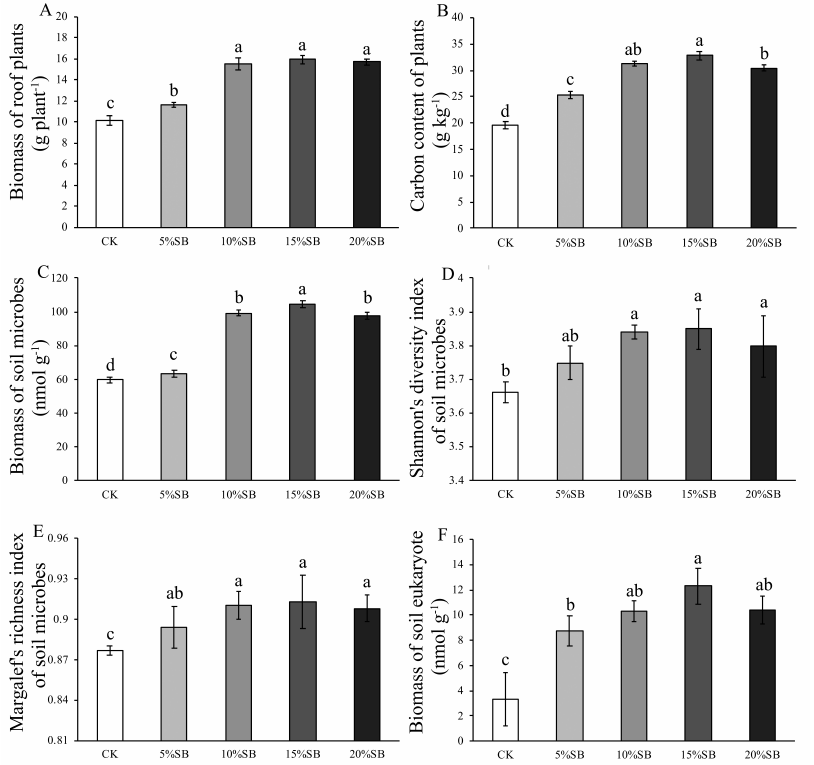
Figure 2. Biological indicators of green roofs. ( A ) Biomass of roof plants. ( B ) Carbon content of plants. ( C ) Biomass of roof soil microbes. ( D ) Shannon’s diversity index of soil microbes. ( E ) Margalef’s richness index of soil microbes. ( F ) Biomass of roof soil eukaryotes. The significant differences ( p < 0.005) between biochar treatments are shown as different lowercase letters on the top of each column. Error bars represent standard errors ( n =